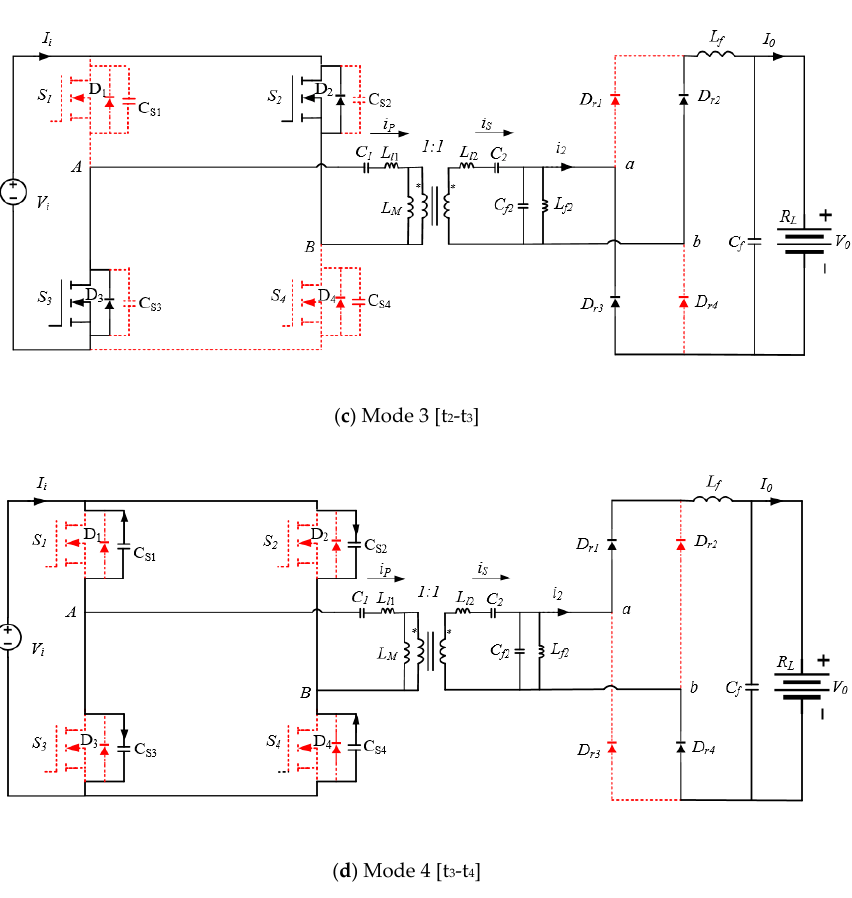
Figure 3. Equivalent circuit for switching mode ( a ) Mode 1 [t 0 -t 1 ]; ( b ) Mode 2 [t 1 -t 2 ]; ( c ) Mode 3 [t 2 -t 3 ]; ( d ) Mode 4 [t 3 -t 4